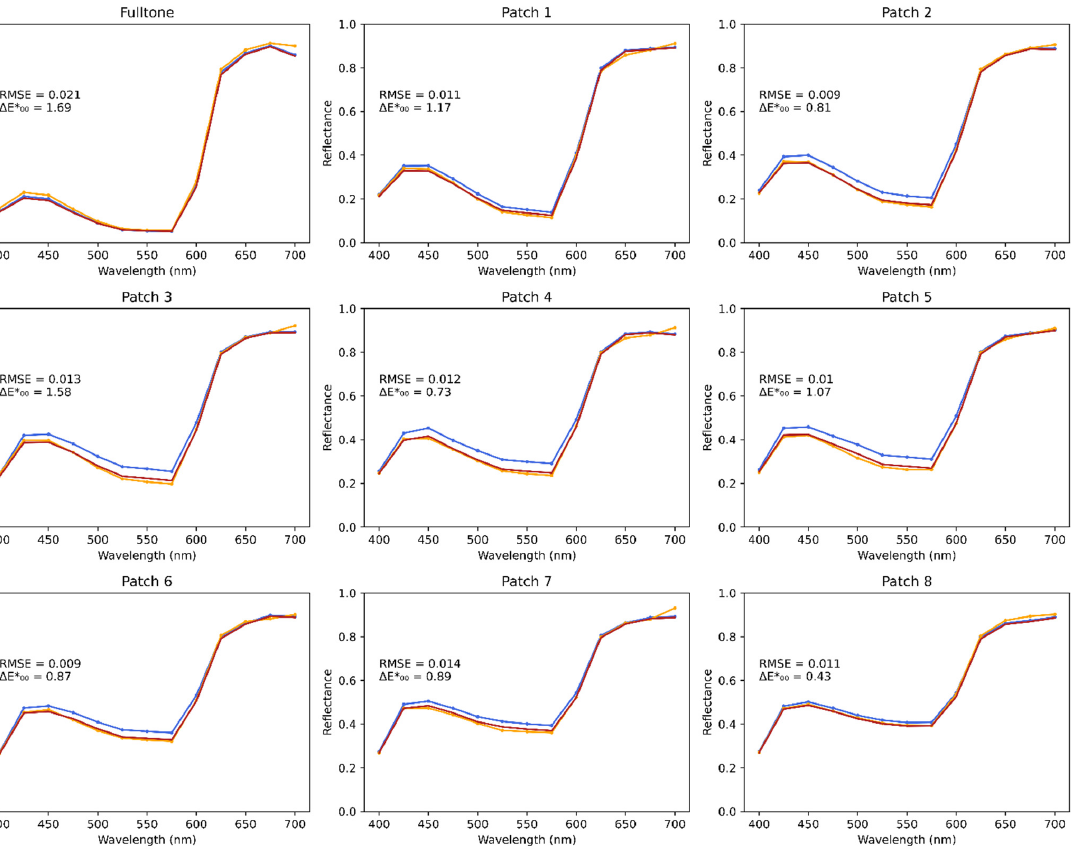
Figure 7. Spectra of the magenta line halftones, averaged over the spatial dimension. Patch 1 to 8 have a period of respectively: 0.168, 0.252, 0.337, 0.421, 0.505, 0.839, 1.263, and 2.104 mm. A specular component of 0.04 is added to all spectra. The optical model gives a prediction of the reflectance of the coated halftones. On each graph are displayed the root mean square error between the predicted spectrum and the experimental one, as well as the color difference with the Δ𝐸 (cid:2868)(cid:2868)∗ determined with the 2° observer, illuminant D65, and a perfect reflector as white reference. There is a good match between the predictions given by the model and the experimental coated-halftone reflectances, which validates the model in the spectral dimension. Experiment on cyan line halftones displays similar results, presented in Figure 8. Thanks to the multispectral microscope setup, spatial reflectances can also be stud- ied. They are presented in Figure 9 for magenta halftones and Figure 10 for cyan halftones.